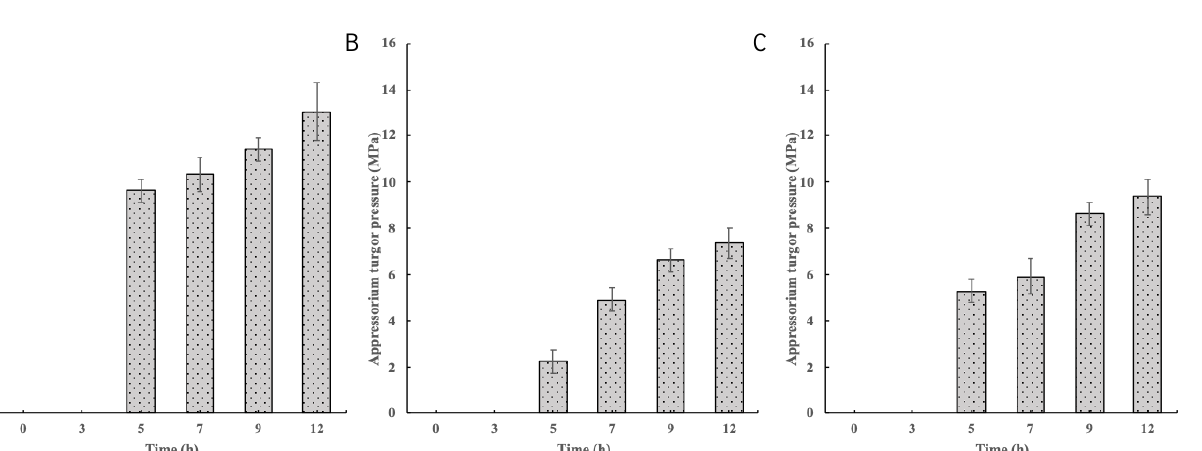
Figure 3. Relative expression of CgCmr1 ( A ) and CgPks1 ( B ) in the wild-type control at different time points. * Significant differences among time points as determined by the t -test ( p < 0.05). 2.3. Transcriptome Sequencing and Data Assembly On the basis of the above-mentioned results, we sequenced the transcriptome of the conidia (0 h) and mature appressorium (12 h) of the C. gloeosporioides WT strain to explore the effect of the DHN melanin biosynthesis pathway on the appressorium turgor pressure. The raw reads generated for the C. gloeosporioides CgWT0h and CgWT12h samples com- prised 7,534,480,292 and 6,803,953,388 bp, respectively (Table 1). The adapter sequences, reads with ambiguous nucleotides, and low-quality reads were eliminated to obtain the clean reads for the CgWT0h and CgWT12h samples. More than 85% of the reads in all six samples had a quality score exceeding Q30 and the Q30 percentage for all samples was not less than 93.94% (Table 1), reflecting the high quality of the sequencing data. Addi- tionally, more than 5.53 Gb clean bases were obtained per library. Table 1. Quality of the sequencing data for the CgWT0h and CgWT12h samples. Note: CgWT0h, C. gloeosporioides wild-type conidia; CgWT12h, C. gloeosporioides wild-type mature appressorium. Sample